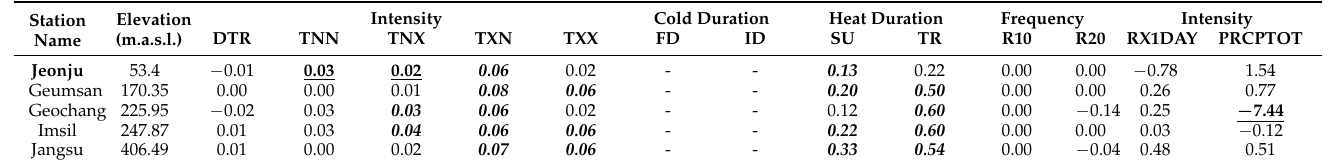
Table A4. Trend magnitudes during summer season (JJA) in the UGRB for 33 years (1988–2020).